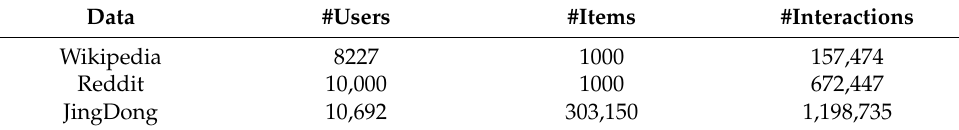
Table 2. Statistics of the two